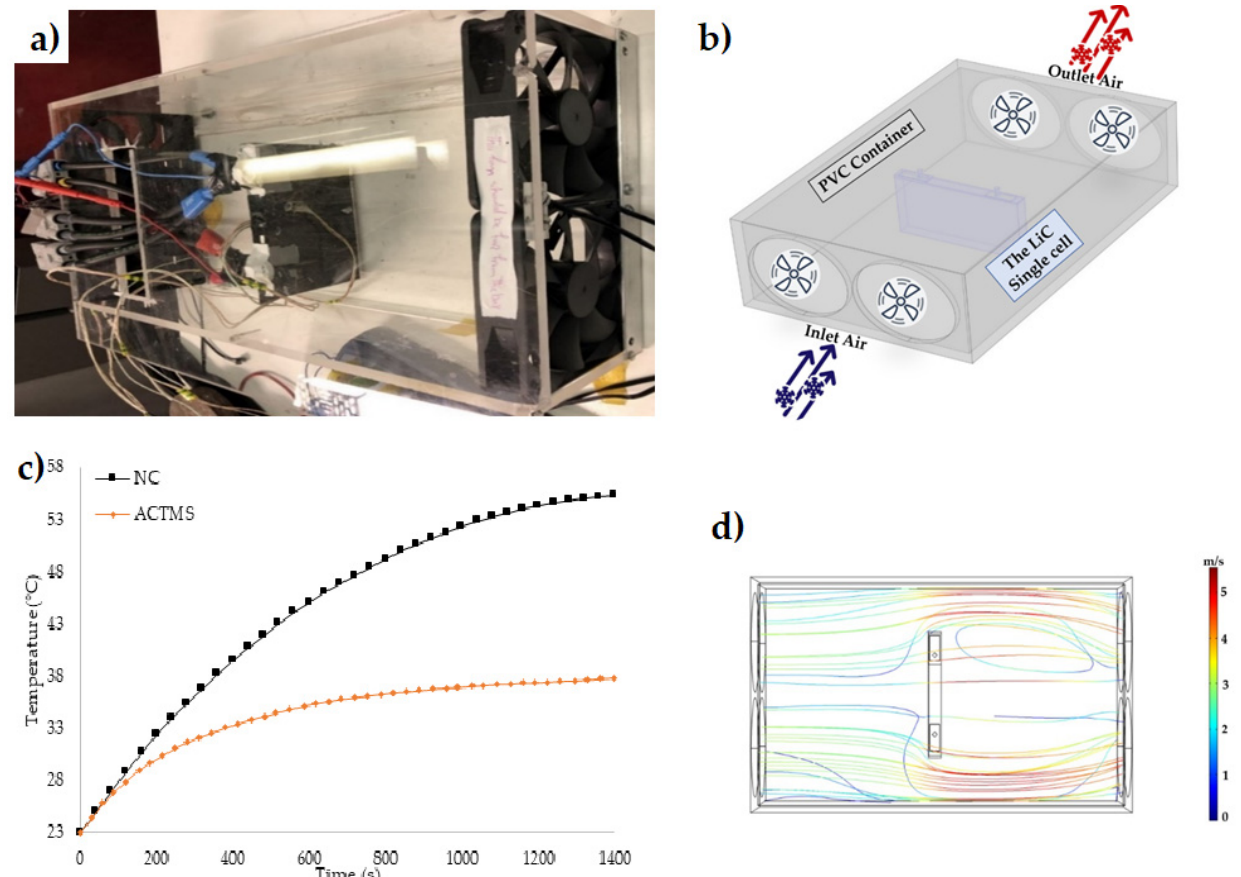
Figure 3. ( a ) The experimental test bench of the air-cooled system for the 2300 F LiC; ( b ) the 3D model; ( c ) comparison of the results where there is not any TMS (NC) by the air-cooled TMS (ACTMS); ( d ) the streamline of velocity [16].